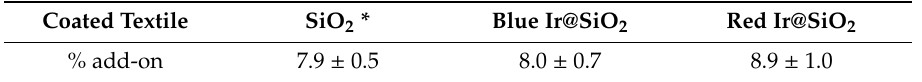
Table 1. Add-on per cent values evaluated for three layers coated textiles.